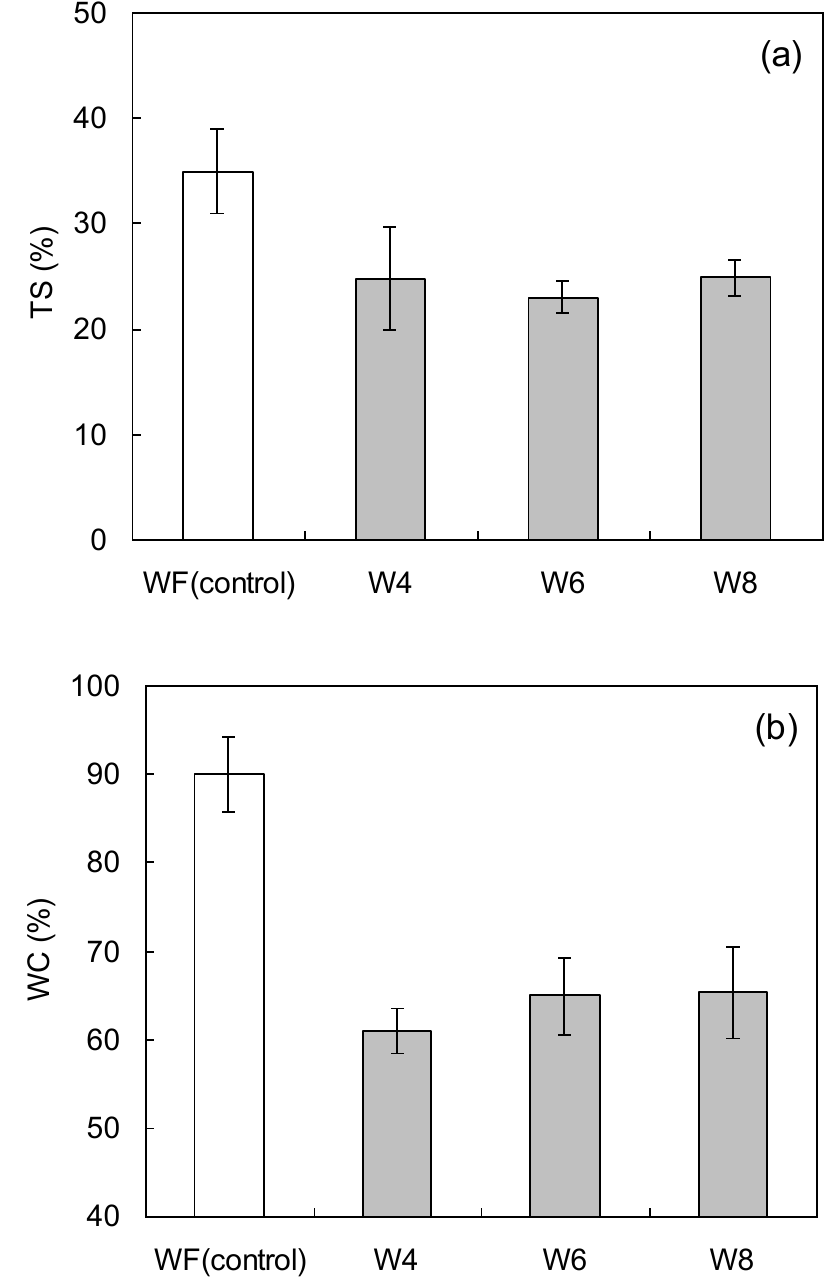
Figure 4. ( a ) Thickness swelling (TS) and ( b ) weight change (WC) of wood flour/LCNF composites are given following water absorption as a function of pulverization setting. The vertical bars indicate a single standard deviation. WF: wood flour.